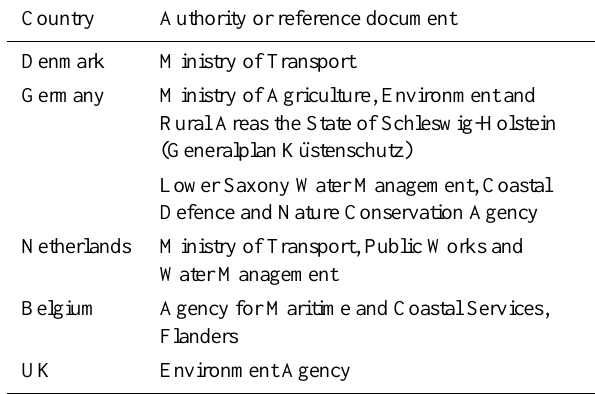
Table 1. Data sources for the coastal protection.